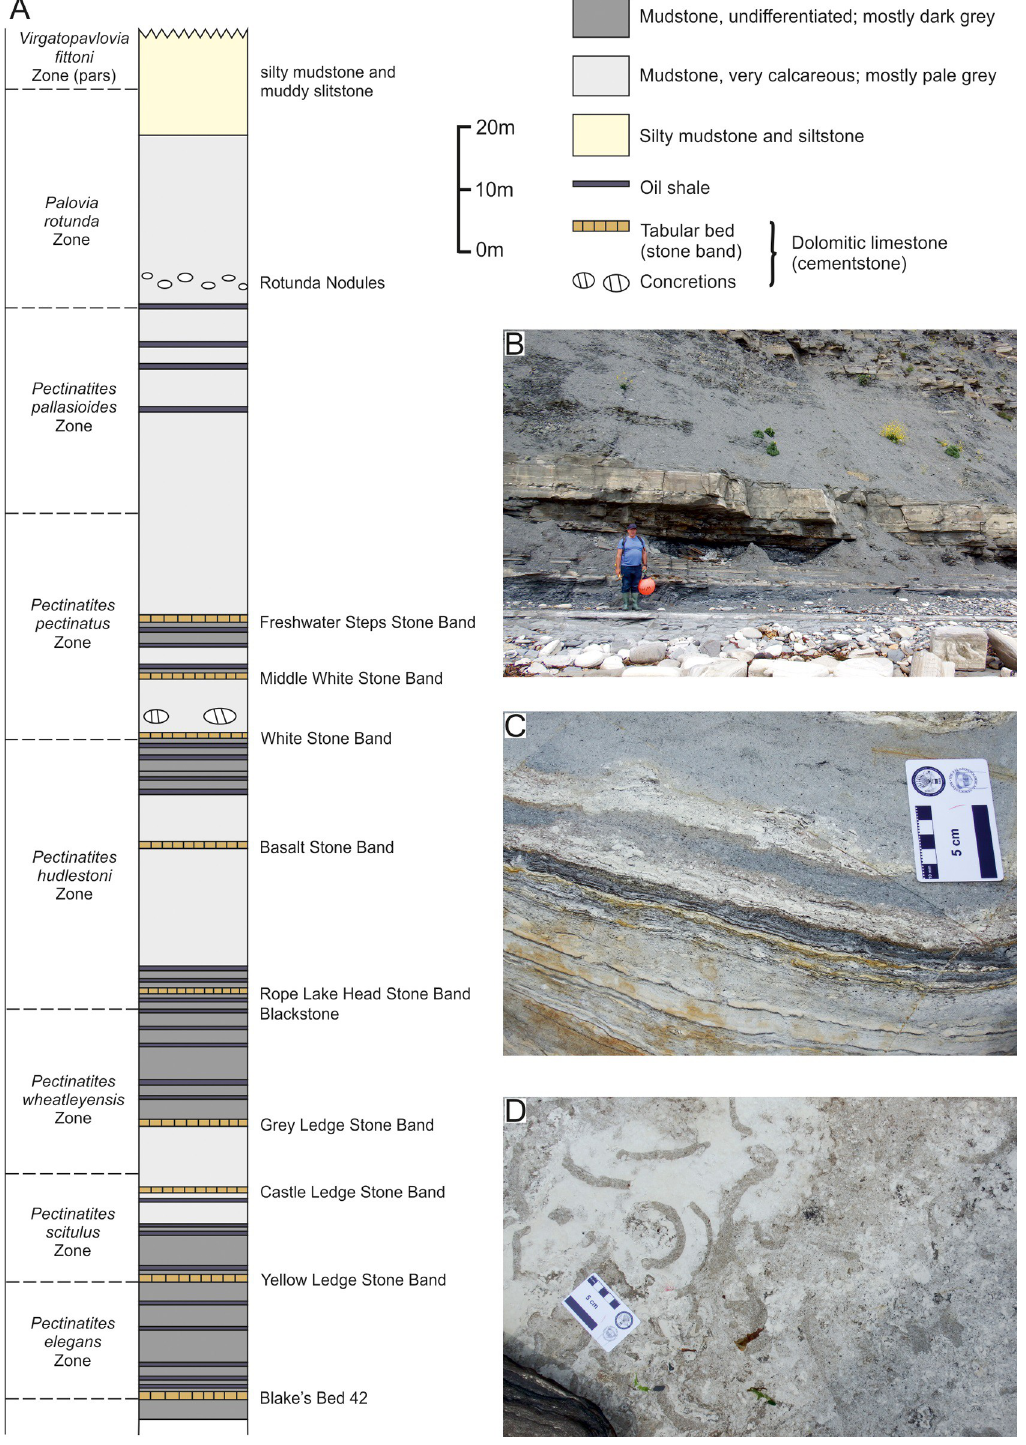
Fig 3. A, Generalised sedimentary log of the exposure from Kimmeridge Bay to Chapmans Pool, with ammonite zonation. Stratigraphy and ammonite zonation after Cox & Gallois [26]. B, exposure of the White Stone Band at beach level. C, laminae on a fallen block with an organic rich layer. D, bioturbation on a bedding surface on a fallen block. Scale bar for B, C and D represents 50 mm.